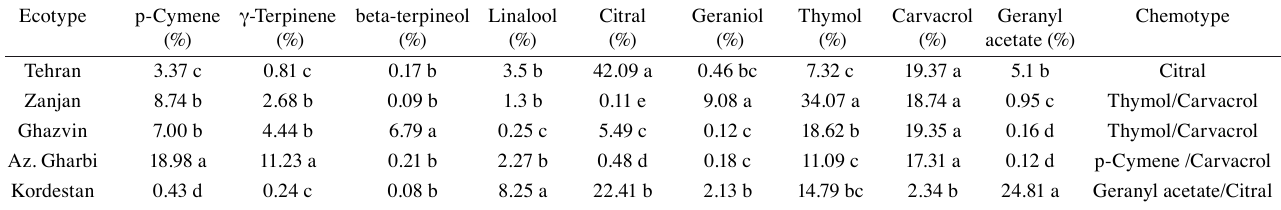
Tab. 7: Major constituents in essential oil of different ecotypes of T. kotschyanus Ecotype